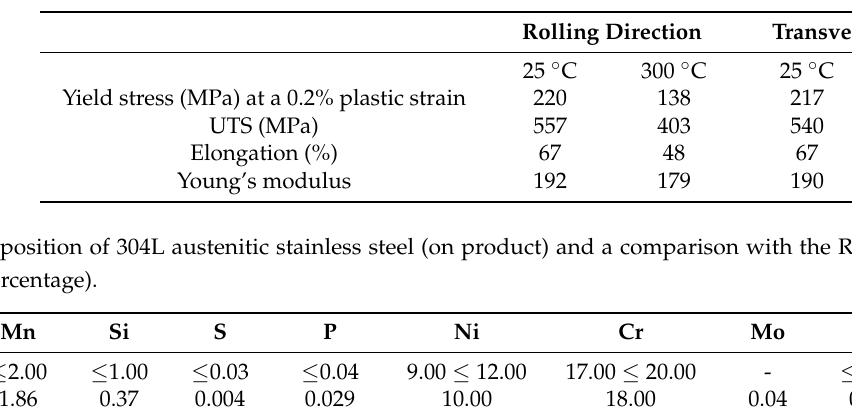
Table 1. Mechanical properties of 304L austenitic stainless steel.